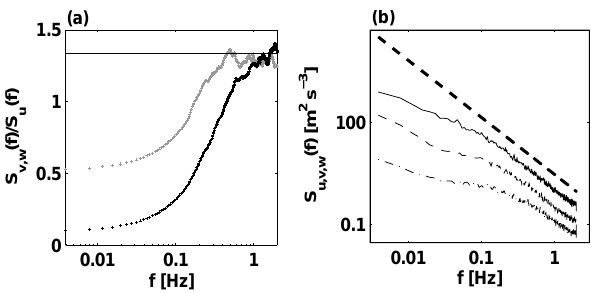
Fig. 4. (a) The ratio between the transverse v and streamwise u ve- locity spectra (grey marks) and between the vertical w and stream- wise u velocity spectra (black marks) showing the approach to the 4/3 ratio required by local isotropy (horizontal solid line), and (b) a log-log representation of u (thin solid line), v (thin dashed line) and w (thin dashed-dotted line) velocity power spectrum densities for the strongest 4h bora interval. The black thick dashed line is the − 5/3 slope. The v and w spectra have been reduced by a factor of 4 and 10, respectively, for